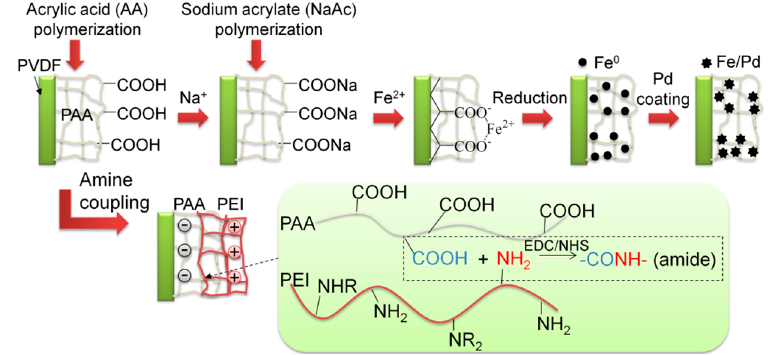
Figure 3. Fe/Pd nanoparticle and amine functionalized membrane synthesis via surface modification.